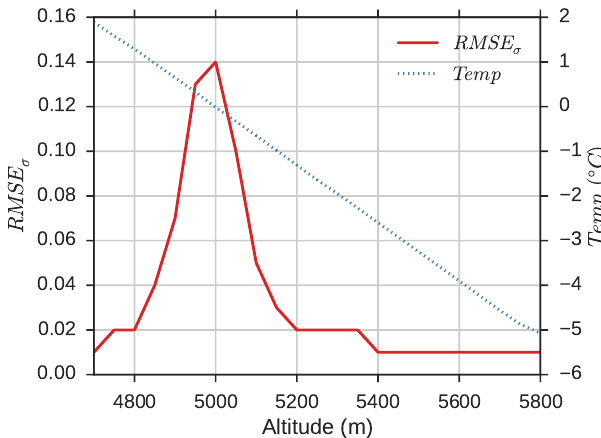
Figure A1. Results of the “perfect downscaling” experiment (see Appendix A1): RMSE σ and Temp for each 50m altitude slice at Shallap